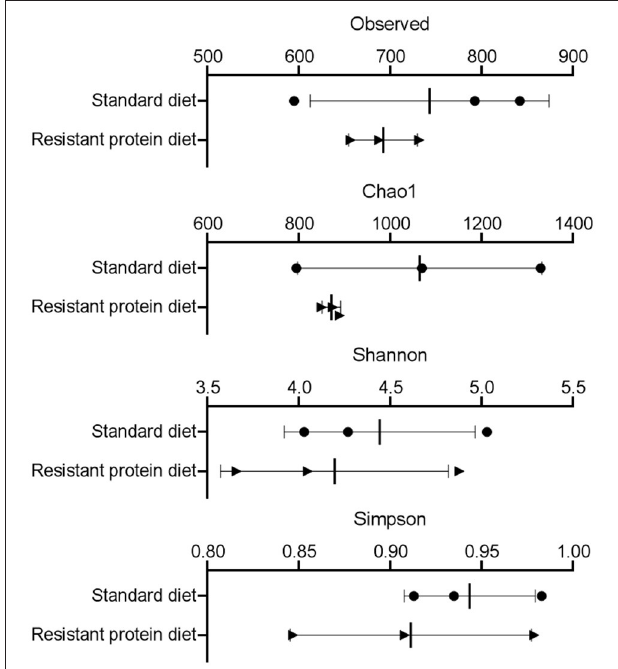
FIGURE 4 | The effects of standard and resistant protein diet on pig microbiota at day 20 showing effects on scores of α -diversity by measures of Observed taxa, Chao1, Shannon, and Simpson indices ( n = 3 pigs per treatment). Results represent the mean and SD of data, with dots indicating individual data points. There was no significant difference between diets on α diversity (all p > 0.05).